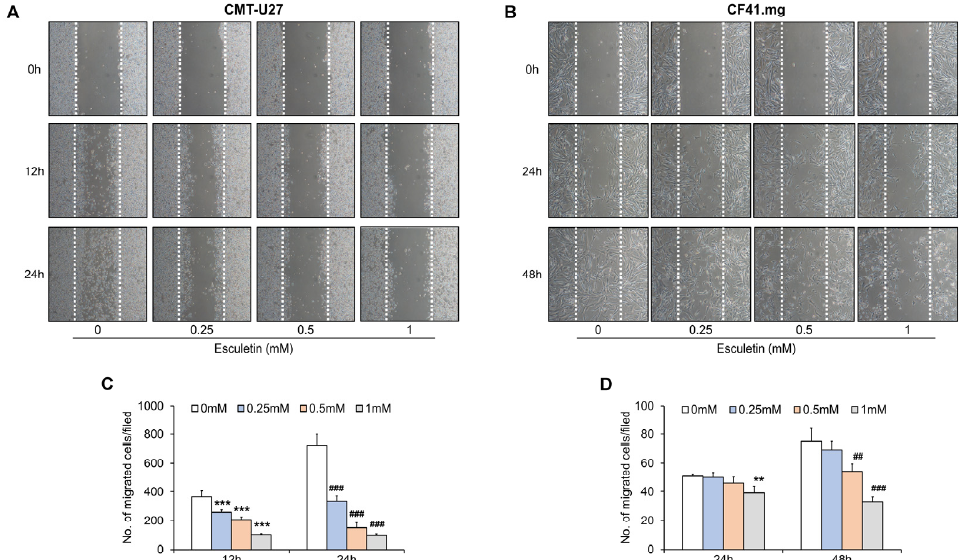
Figure 2. Esculetin suppresses migration of CMT cells. ( A – D ) Images and quantification of migration in CMT-U27 ( A , C ) and CF41.mg ( B , D ) cells after esculetin treatment in a dose- and time-dependent manner. Magnification, 40 × . Values are mean ± SD. ** p < 0.01, *** p < 0.001; ## p < 0.01, ### p < 0.001 versus untreated cells by one-way ANOVA followed by Bonferroni post-test.